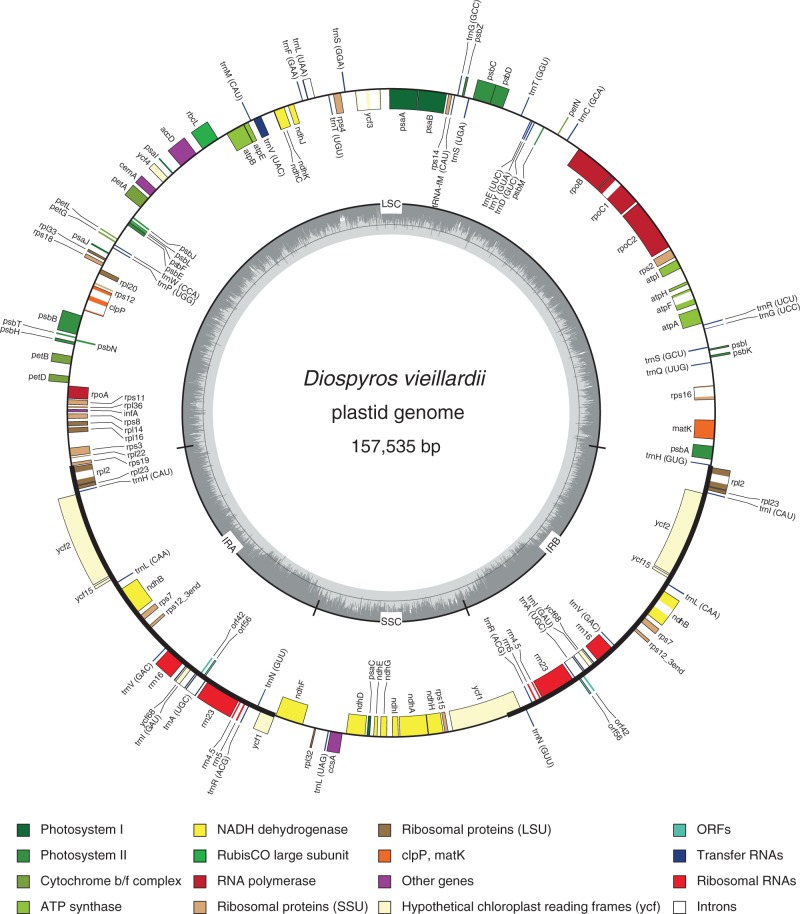
Graphic representation of the annotated plastid genome of Diospyros vieillardii.